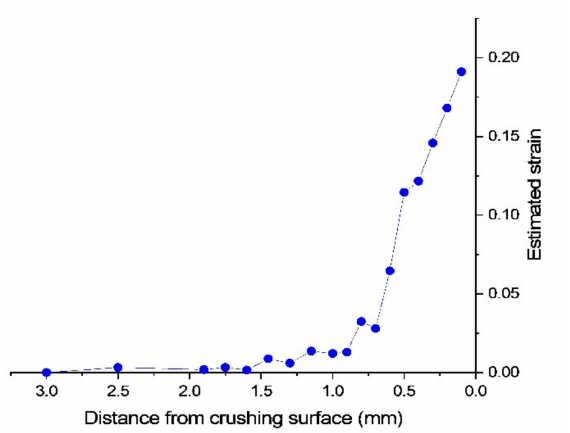
Figure 8. Variation in assumed strain with distance from the work hardened surface of the